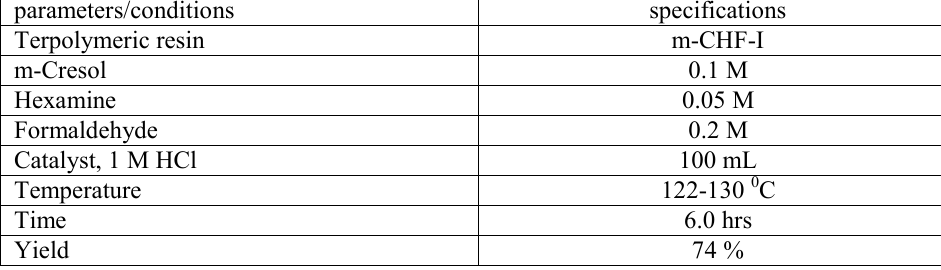
Table 1: Synthetic details of m-CHF-I.